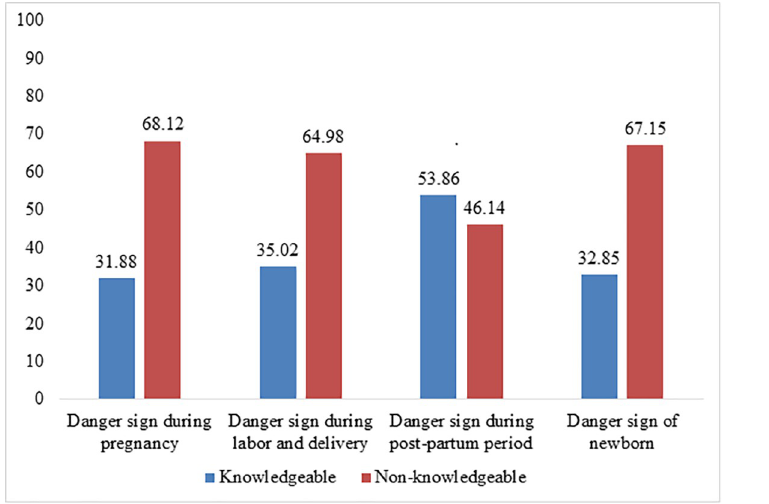
Fig 2. Knowledge of danger signs among pregnant